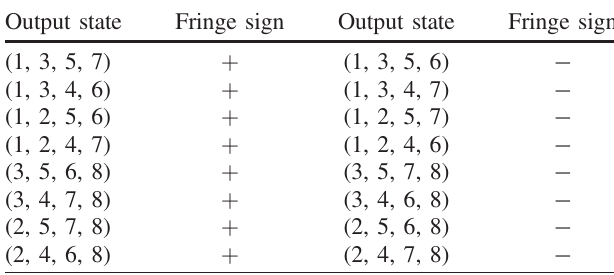
ffiffiffiffi p N for a given number